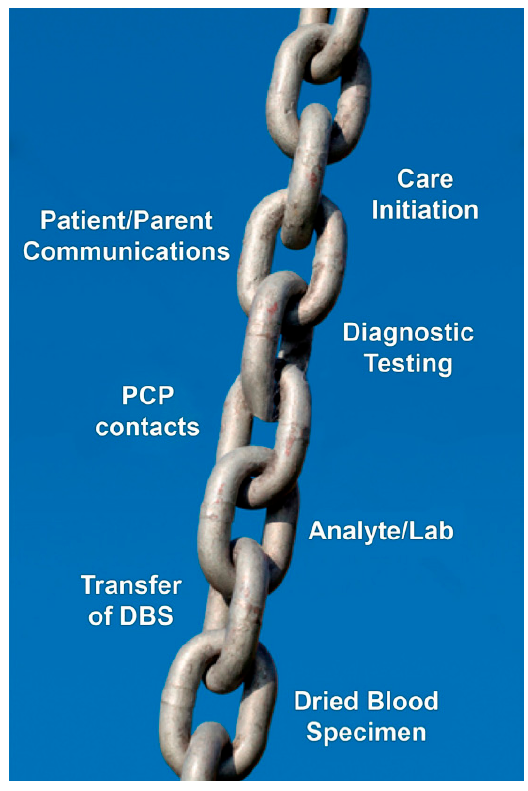
Figure 2. The sequence of processes and procedures linked together like a chain in the system of early diagnosis via newborn screening, reminding us that “a chain is only as strong as its weakest link.” Abbreviations include PCP—primary care provider; DBS—dried blood specimen.